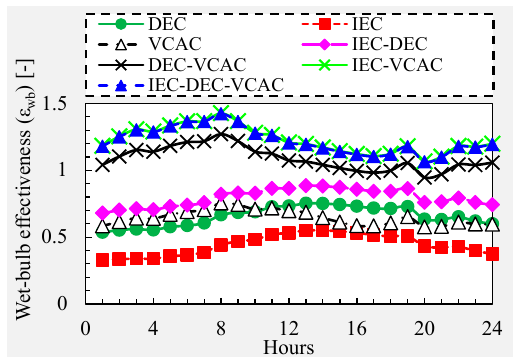
Figure 10. One-day-averaged variation of wet-bulb effectiveness of the seven AC configurations.